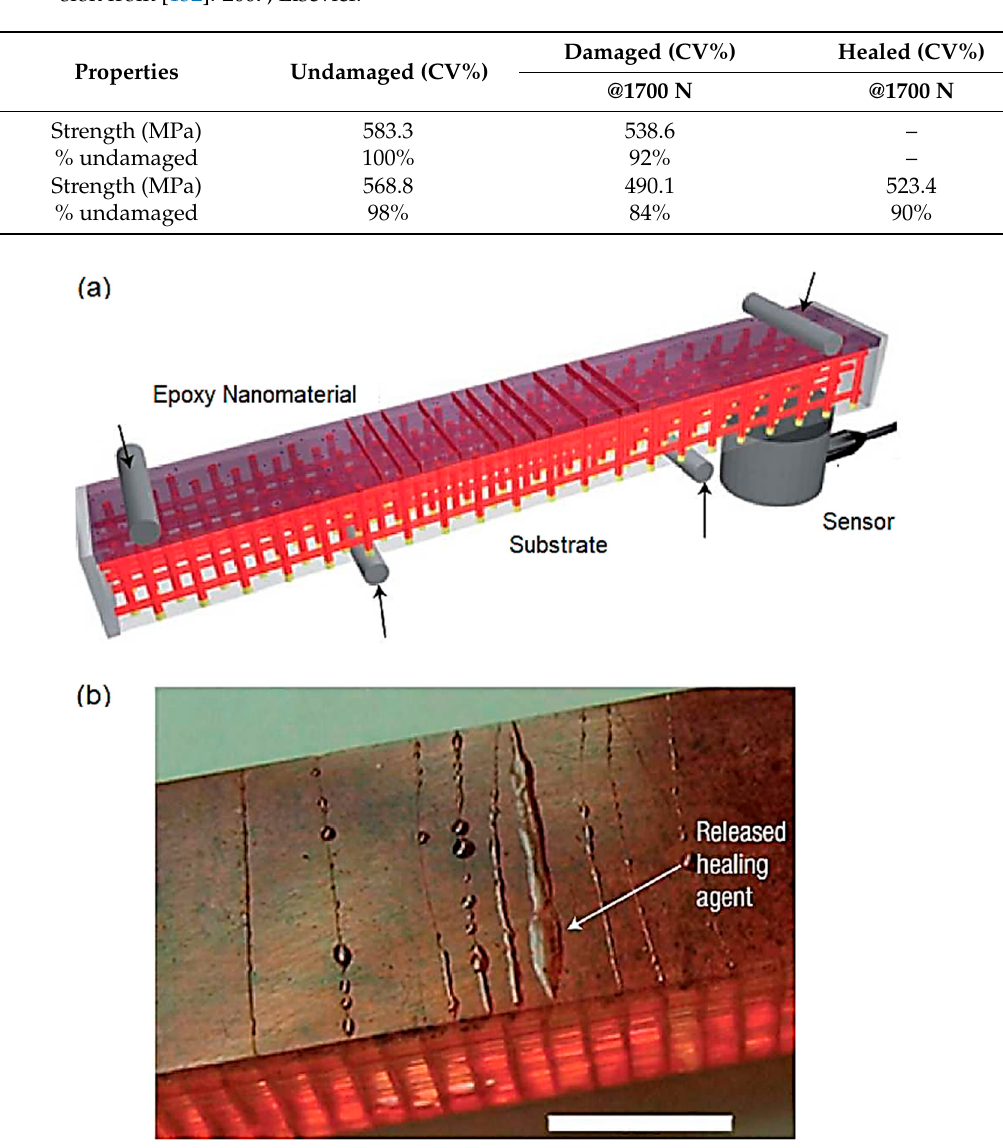
Figure 13. ( a ) Schematic of microvascular substrate; ( b ) optical image of actual microvascular system after damage. Reprinted with permission from [136]. 2007, Nature.